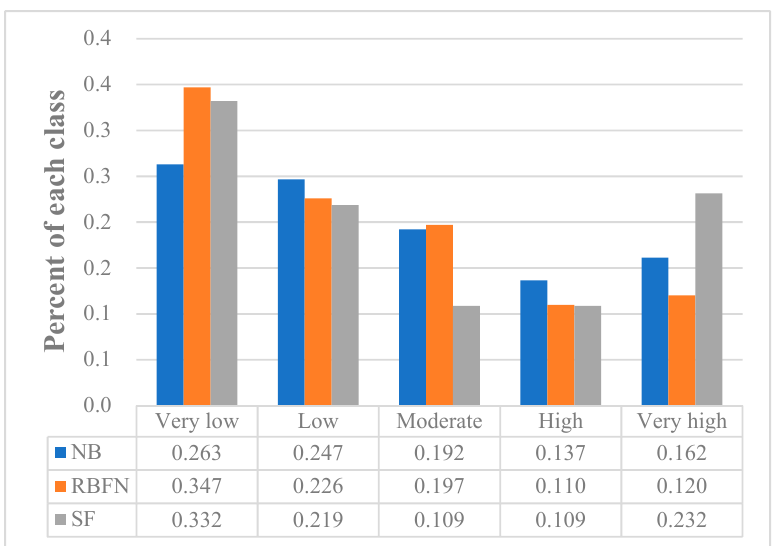
Figure 6. Histogram of landslide susceptibility classes.